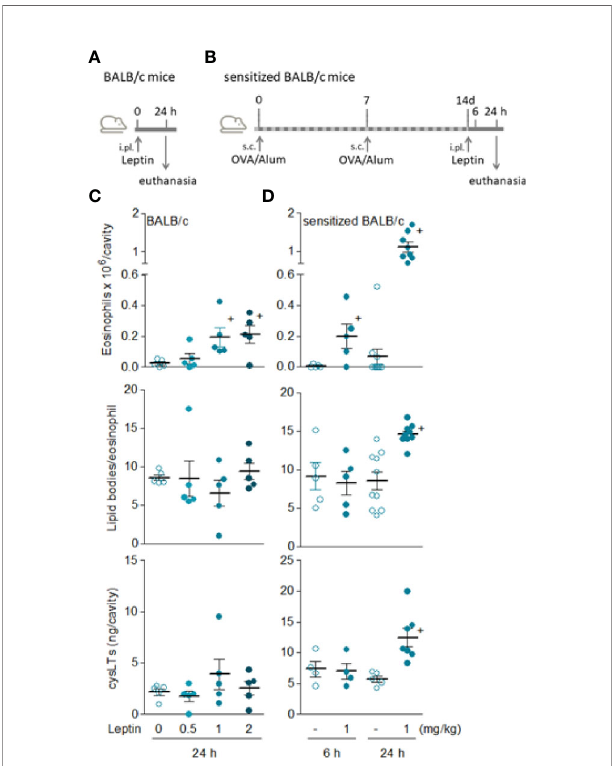
FIGURE 2 | Leptin induces both in vivo eosinophil migration and activation in sensitized BALB/c mice. (A, B) show, respectively, brief schematic representations of pleurisy models induced by i.pl. injection of leptin in naïve [data shown in (C) ] and sensitized [data shown in (D) ] BALB/c mice employed in this study. In (C) , naïve BALB/c mice received i.pl. injection with different concentrations of leptin (0.5, 1 and 2 mg/kg) and pleural fl uids were collected within 24 h. In (D) , sensitized BALB/c mice received i.pl. injection of leptin (1 mg/kg) and pleural fl uids were collected within 6 or 24 h, as indicated. Analyses include pleural eosinophil counts evaluated in cells stained by May-Grünwald-Giemsa (upper panels), numbers of cytoplasmic lipid bodies counted within osmium-stained pleural eosinophils (middle panels) and cysLTs levels found in cell-free pleural fl uids measured by speci fi c EIA kit (bottom panels). Values are expressed as the mean ± SEM (experiments were repeated at least once). + p < 0.05 compared to control group.